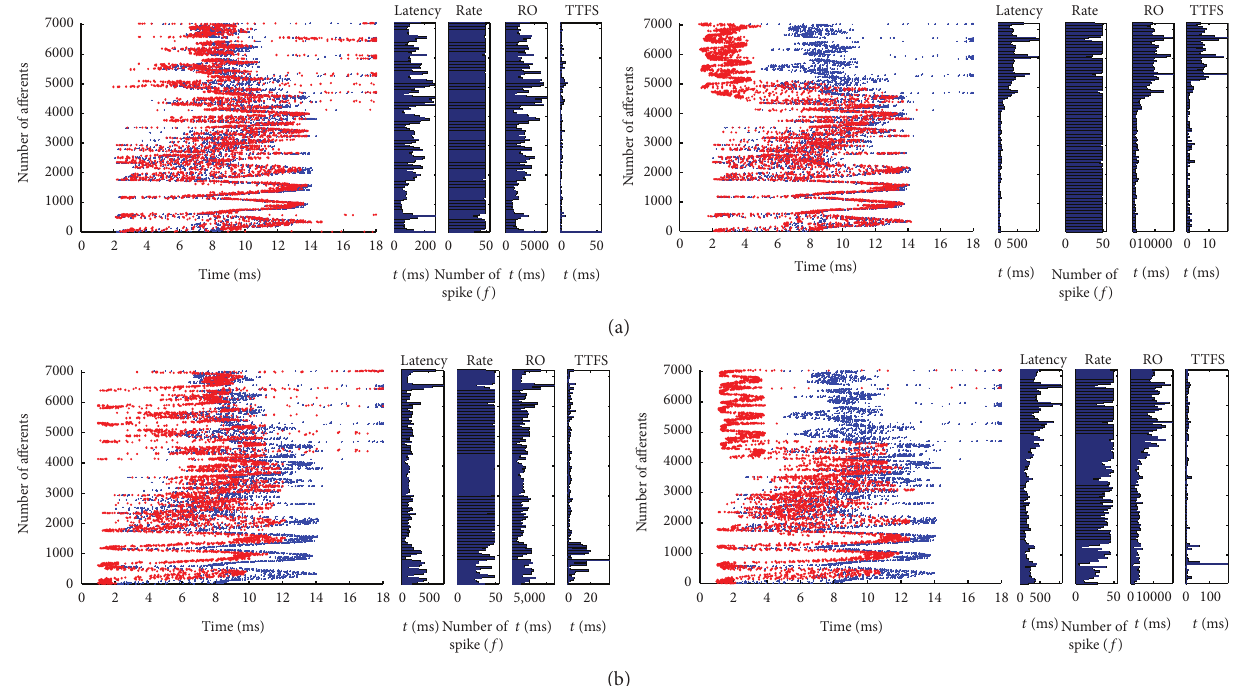
Figure 14: Different spike codings applied to output spikes of CD classifier fully trained by 𝜏 𝑠 Prediction with epoch = 1, taking inputs from AR Scream S1 on the left and AR Scarf S1 on the right. Figures in row (a) are plotted from matching face samples, while in bottom row (b) they are from nonmatching face samples. Scatter plots are comprised of spatiotemporal input spike patterns of reference face (blue asterisk) and test face (red circle) from 7056 neurons afferents while bar plots on the right show the CD neurons latency, rate, rank order, and TTFS coding applied. The input spikes are obtained by direct conversion of pixel values to time domain which is then normalized to be between 0 and 18.